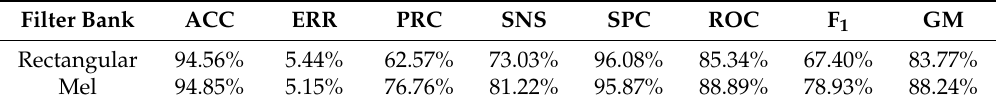
Table 7. Classification performance metrics vs. filter bank frequency scaling.